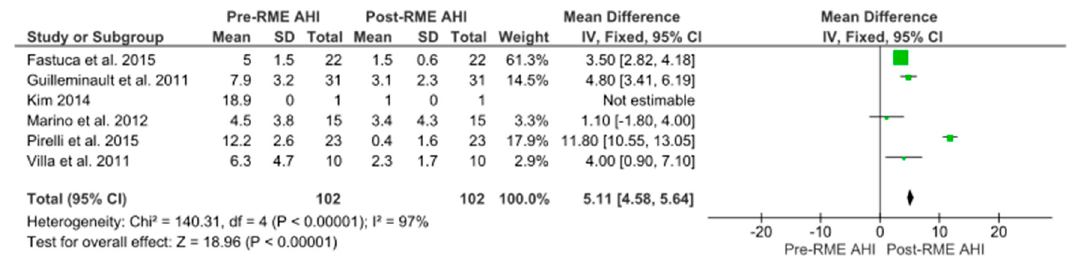
Figure 2. Apnea-hypopnea index (AHI) mean difference and standardized mean difference before and after rapid maxillary expansion (RME). CI = confidence interval; IV = inverse variance; SD = standard deviation.